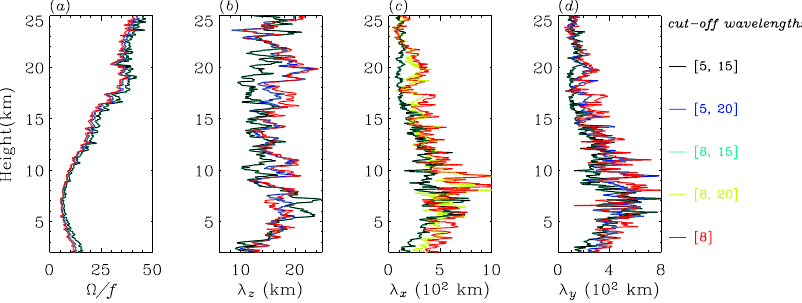
Figure 2. An example of the monthly averaged ratio of gravity wave intrinsic frequency to Coriolis parameter (a) , vertical wavelength (b) , zonal wavelength (c) and meridional wavelength (d) profiles at Miramar Nas (32.87 ◦ N, 117.15 ◦ W), CA, in January 1998. Curves in different colors denote the gravity wave parameters are derived by applying different filters, whose cut-off wavelengths are, respectively, 8 and 20km, 8 and 15km, 5 and 20km and 5 and